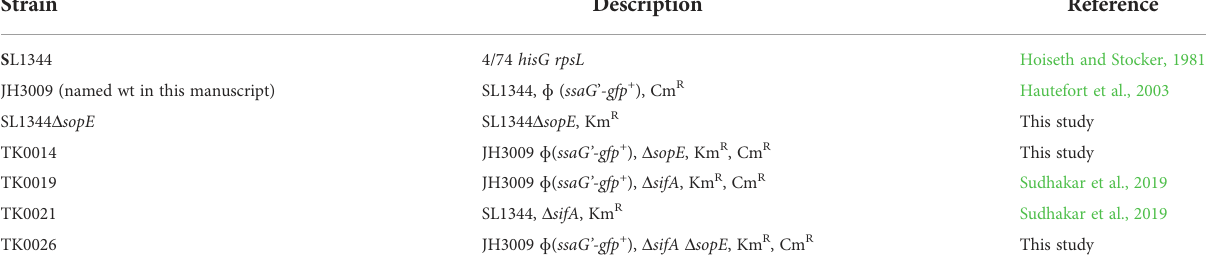
TABLE 1 Salmonella enterica Typhimurium strains, generated and used in this